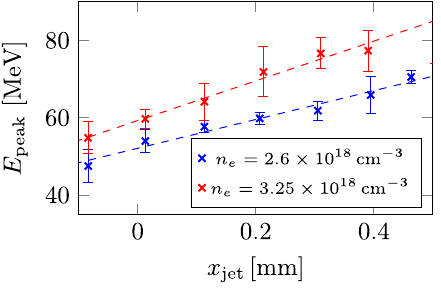
FIG. 4. Peak energy (blue) and total charge (red) against electron number density in the plateau. Each data point corre- sponds to 10 consecutive shots and the error bars indicate one standard deviation in each direction. The peak energy increases linearly (dashed blue line) with the electron number density, whereas the total charge shows no such trend. The electron number density in the peak is kept constant at 11 × 10 18 cm − 3 .